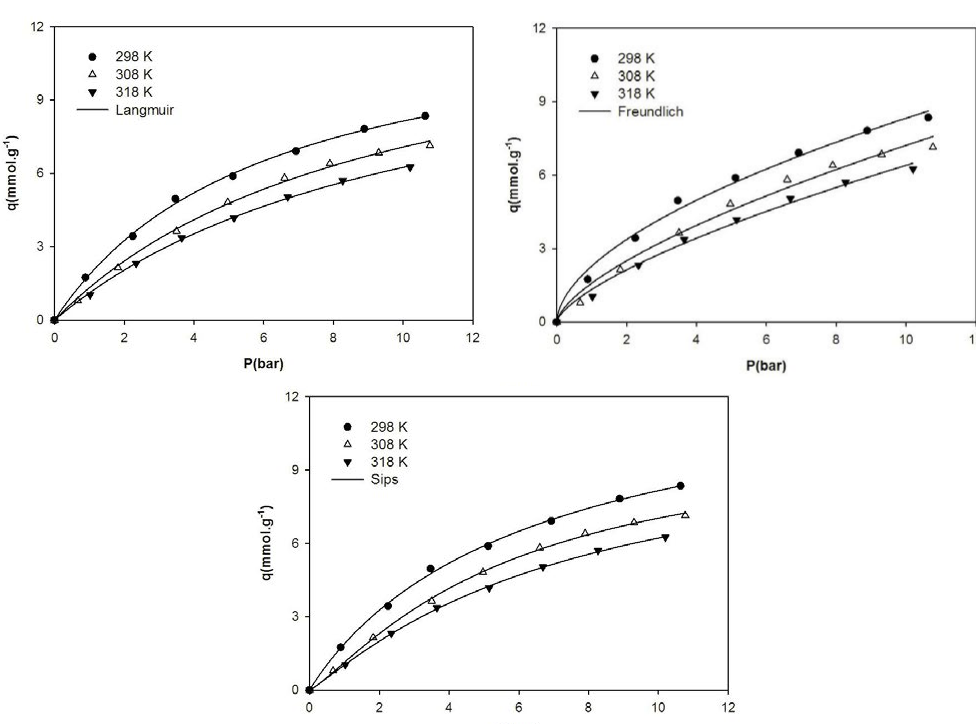
Fig. 6. The nonlinear fit of experimental data with Langmuir, Freundlich, and Sips models.